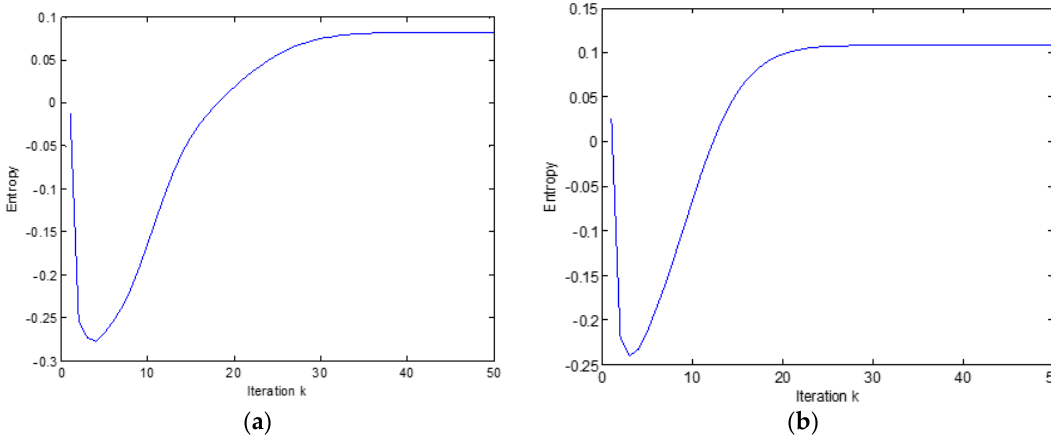
Figure 5. Comparison of entropy sum value of received components, ( a ) INFOMAX algorithm, ( b ) optimization algorithm on a group 𝐒𝐎(4).